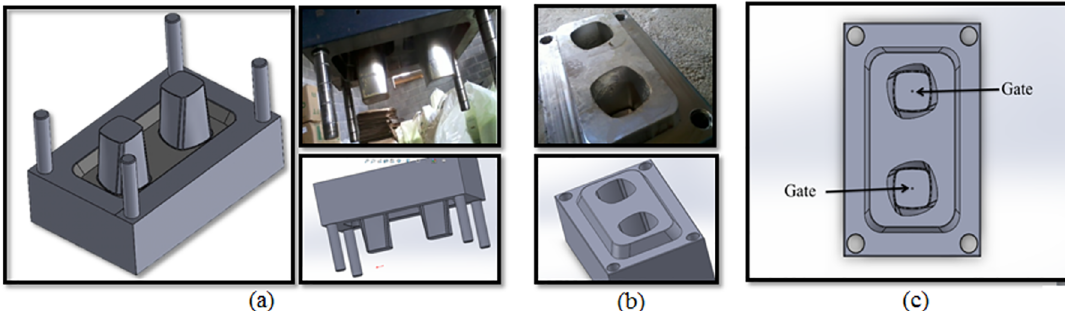
Figure 2. Details of the injection mold: a) inferior cavity virtually developed by using SolidWorks and inferior cavity of the real mold; b) superior cavity virtually developed by using SolidWorks and superior cavity of the real mold; c) position of the injection gates.